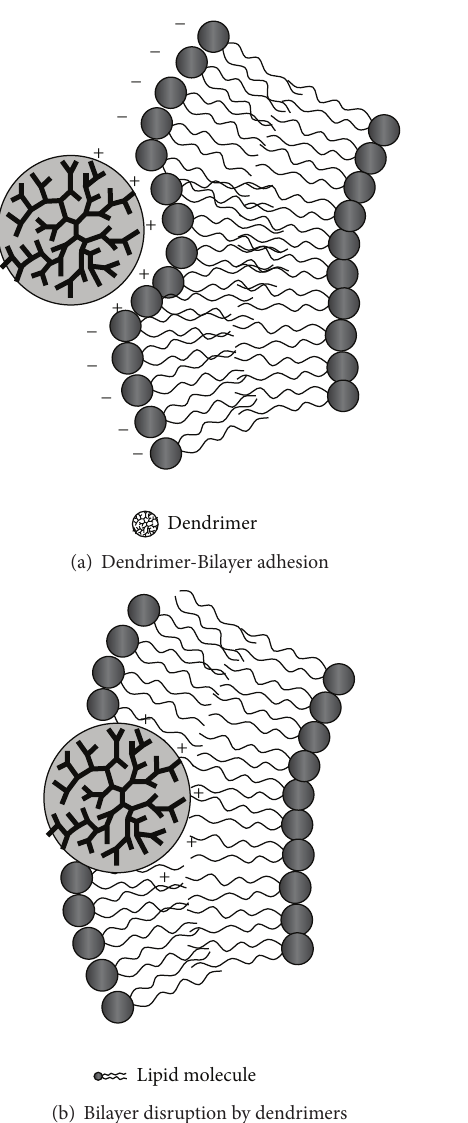
Figure 7: Example of dendrimer-lipid interaction in biomem- branes.